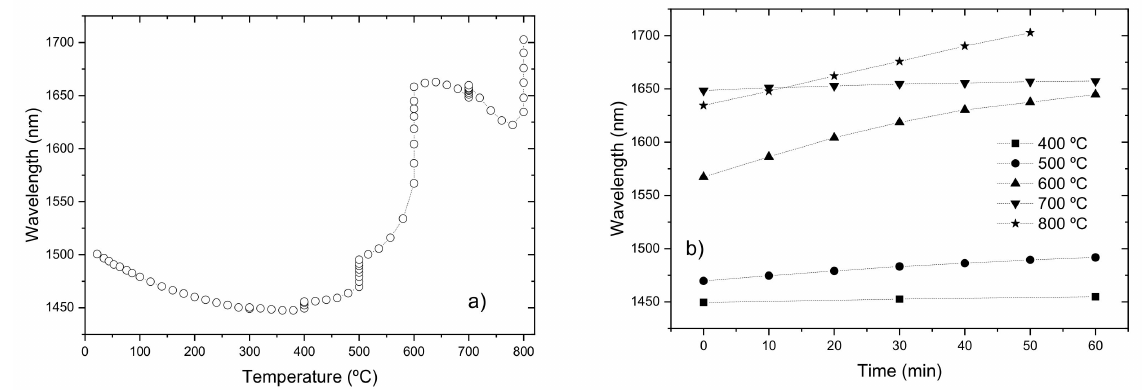
Figure 7. ( a , b ) Heating cycle up to 800 ◦ C with dwell time of 1 h at each step. Reprinted with permission from ref. [96]. © 2021 Wiley Periodicals,